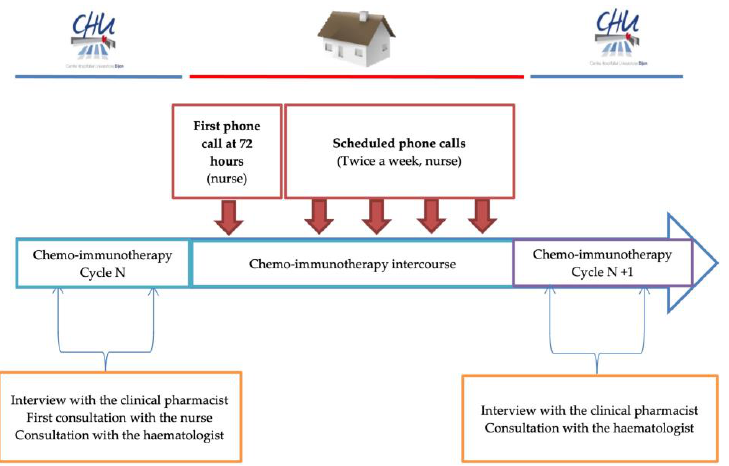
Figure 1. Diagram of the care pathway of the patient participating in the UMACOACH Lymphoma Program.